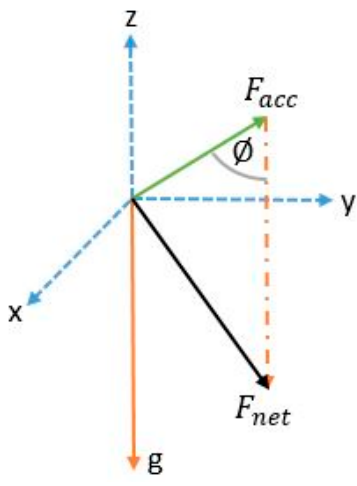
Figure 4. Forces applying to the accelerometer and their equivalent.